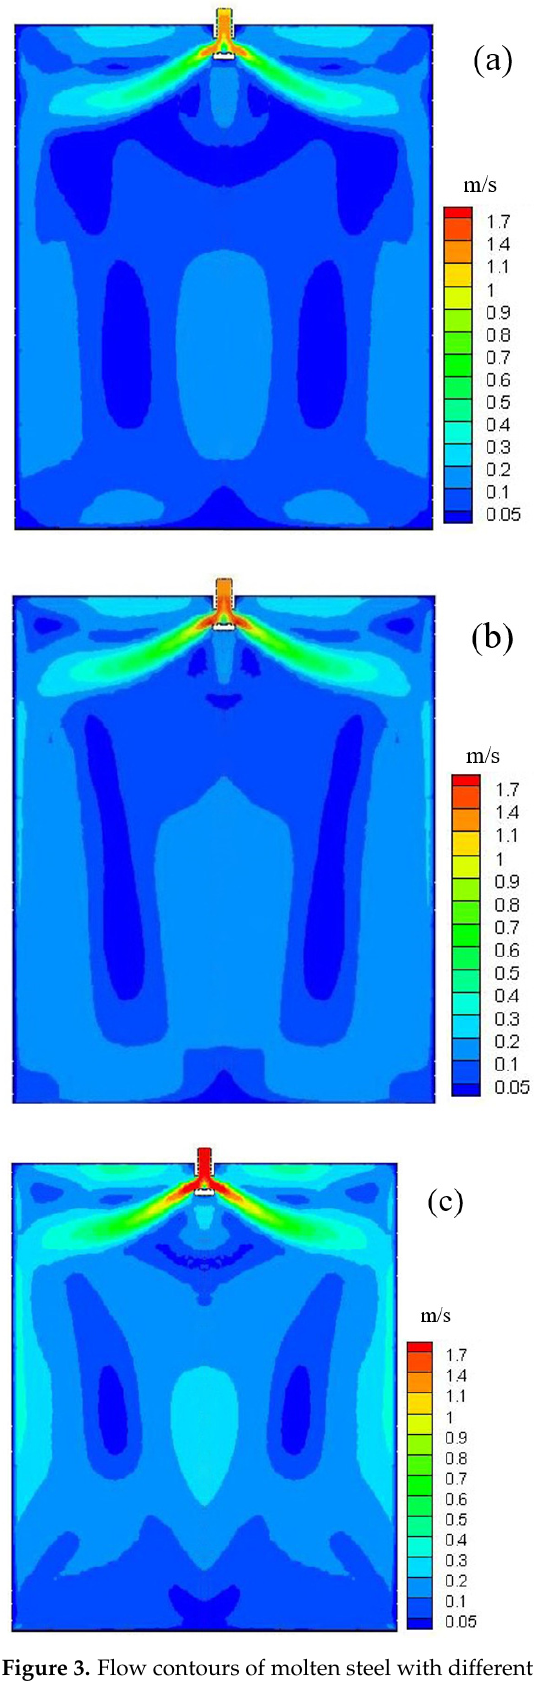
Figure 3. Flow contours of molten steel with different velocities: ( a ) 0.6 m/min; ( b ) 0.8 m/min; and ( c ) 1.0 m/min.